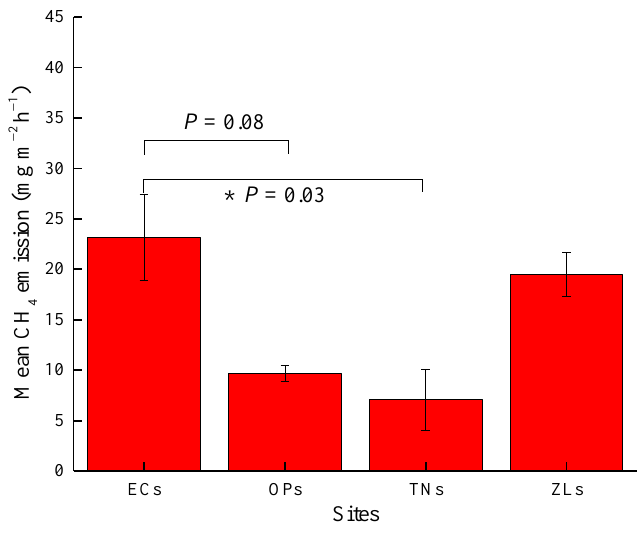
CH 4 emission fluxes at all four sites were significantly positively correlated with air and water temperature (Figure 6a, P < 0.01), and significantly negatively correlated with water depth (Figure 6b, P < 0.01). The CH 4 emission fluxes had no significant correlation with the DO concentration in the water (Figure 7, P > 0.05). Figure 5. Mean CH 4 emission fluxes at the four sites (* indicated the significant levels at 0.05).